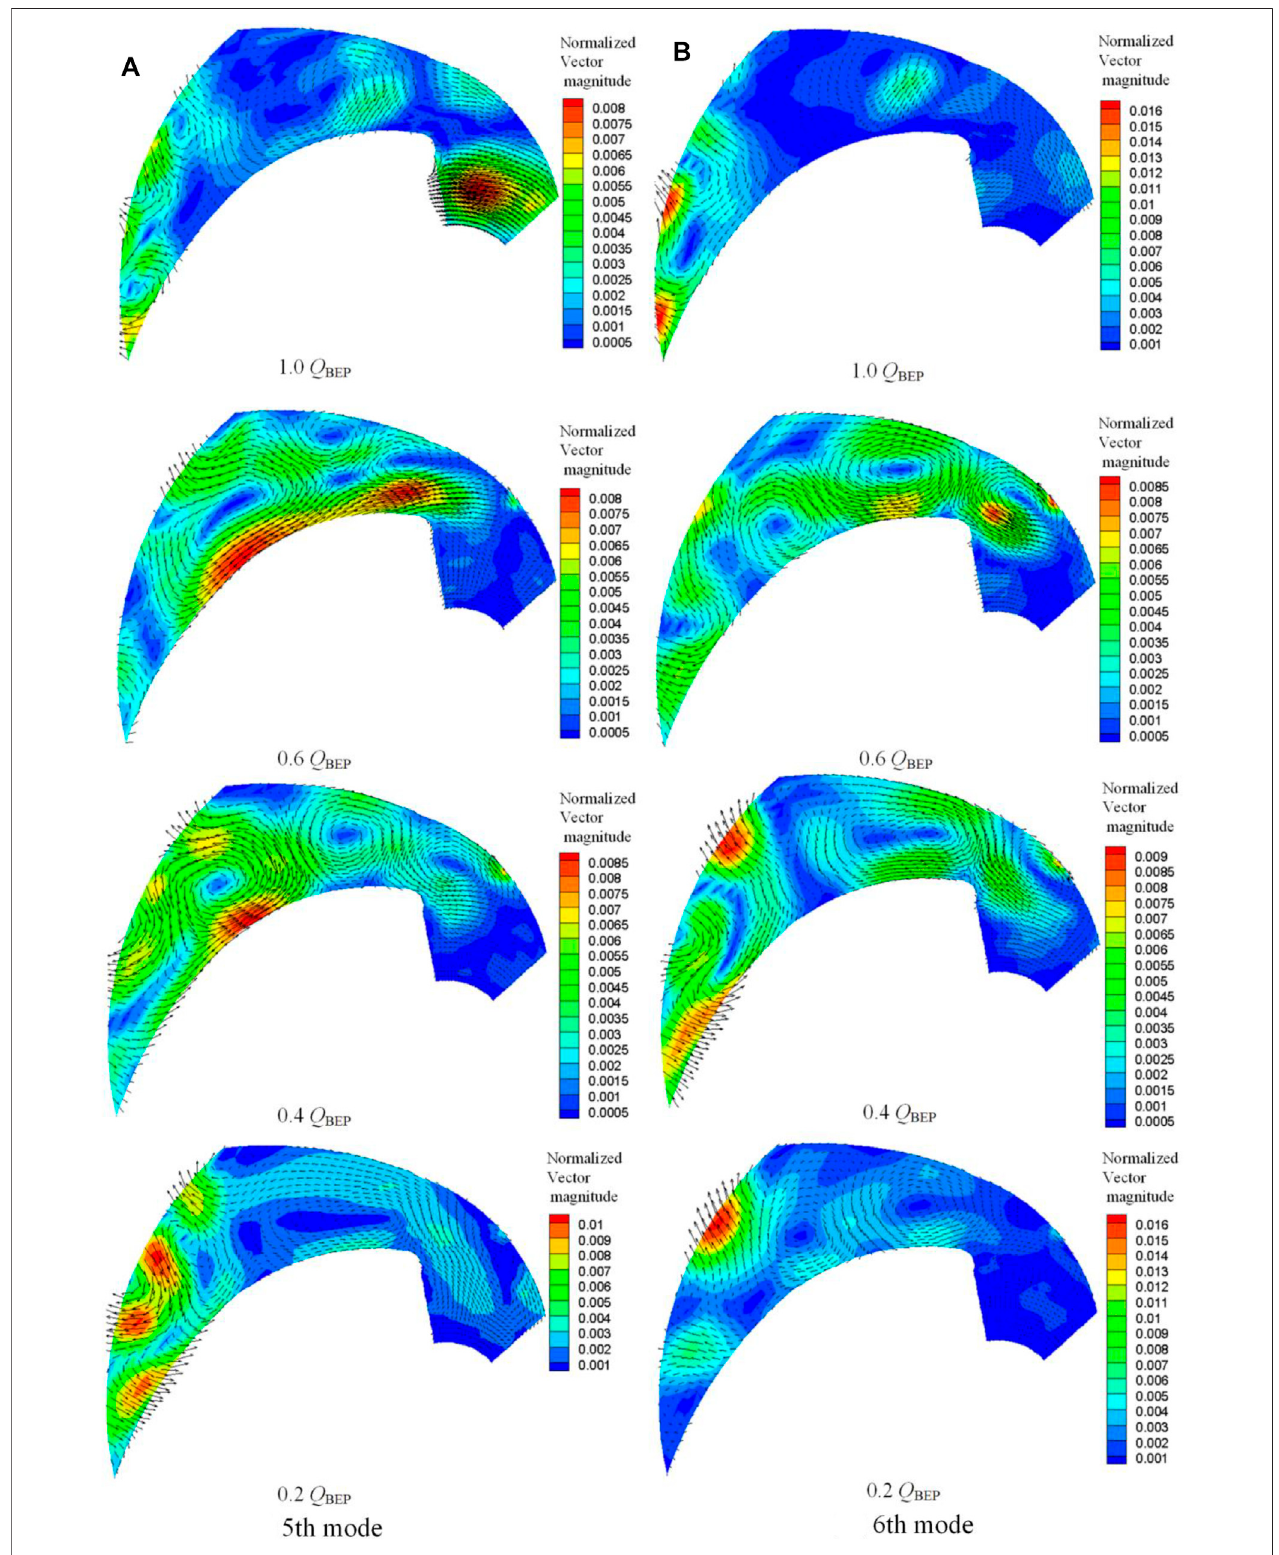
FIGURE 12 | The vector plots of the fi fth and sixth modes for different fl ow rates. (A) Fifth mode, (B) sixth mode.